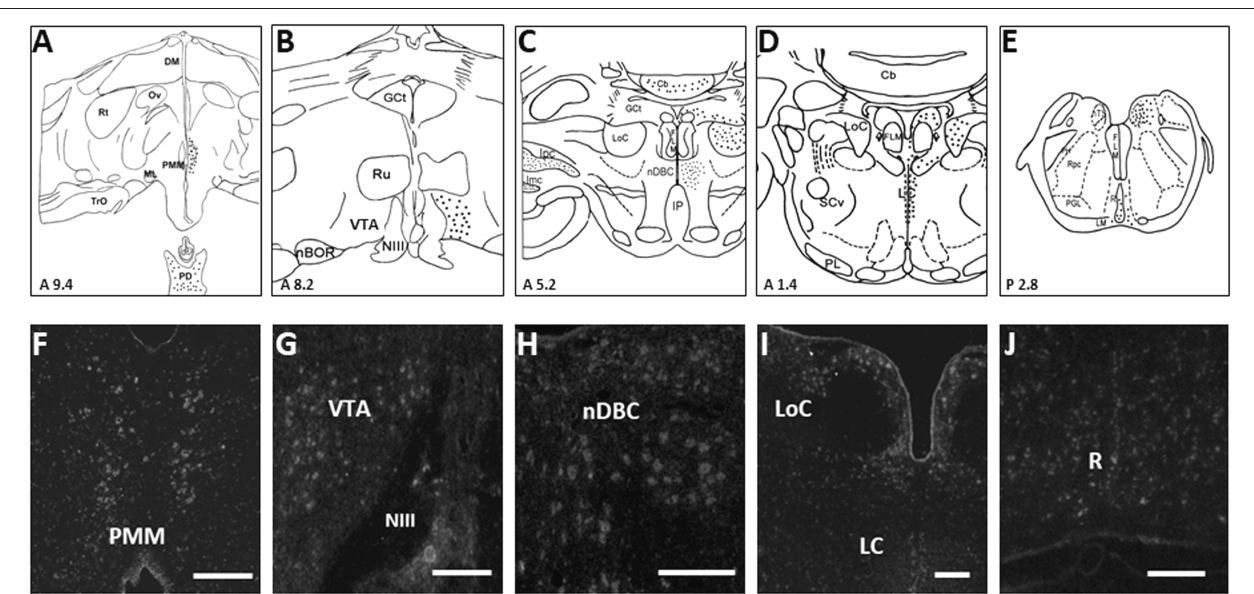
FIGURE 1 | Schematic drawings of rostral-to-caudal (A–E) coronal sections, showing the distribution of turkey Xenopus -like melanopsin (tOpn4x) expression labeled neurons (filled circles) of the turkey hen. Coronal illustrations were drawn from an unpublished turkey brain atlas with nomenclature taken from a chicken atlas ( Kuenzel and Masson, 1988 ) and the revised nomenclature for avian brains (Reiner et al., 2004). Representative photomicrographs (F–J) showing the distribution of tOpn4x mRNA labeled neurons in the PMM, VTA, nDBC, LoC, LC, and R (refer to the abbreviations given below). A specific tOpn4x cRNA probe was used for in situ hybridization histochemistry (ISH). Darkfield photomicrographs of turkey brain sections processed for ISH with 33 P-labeled tOpn4 antisense cRNA probes. Scale bar: 100 µ m (G,H,J) , 200 µ m (F,I) . The following abbreviations are used in the figure: Cb, cerebellum; DM, dorsomedial hypothalamic nucleus; MLF, medial longitudinal fasciculus; GCt, mesencephalic central gray; Ipc, parvocellular nucleus Isthmi; Imc, magnocellular nucleus isthmi; IP, interpeduncular nucleus; LC, caudal linear nucleus; LM, medial lemniscus; LoC, locus coeruleus; ML, lateral mammillary nucleus; nBOR, nucleus of the basal optic root; nDBC, nucleus